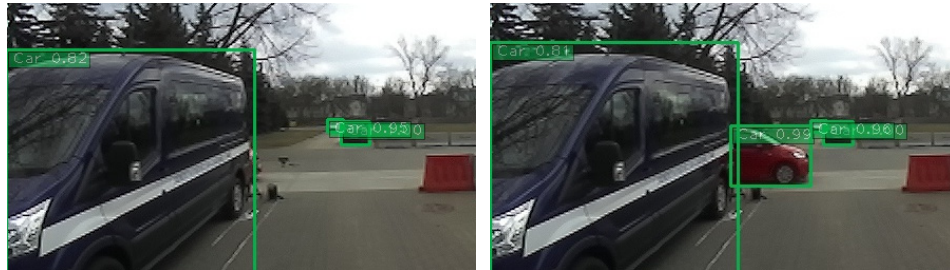
Figure 2. Part of the research: identification of the suddenly appearing obstacle at a road intersection by the AV’s perception system ( Ł ukasiewicz Research Network—Automotive Industry Institute). Two frames from the perception system’s camera are shown; the numerical value in the figure indicates the probability of object identification by the AV system.